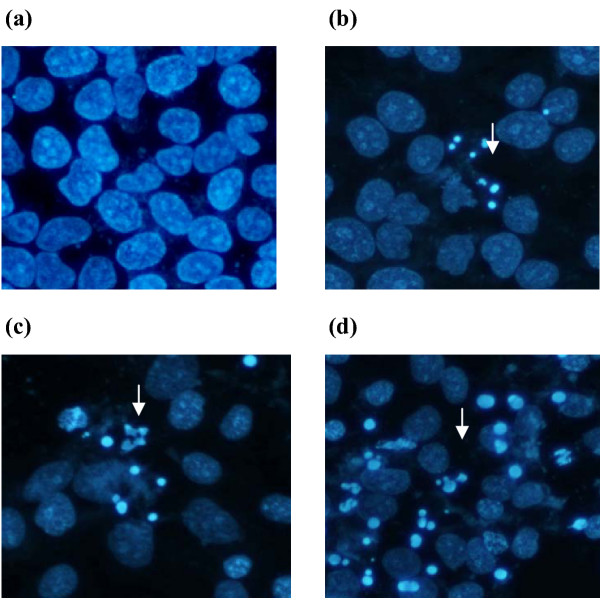
Apoptosis induced by bis-aziridinylnapthoquinone (AZ-1) in BC-M1 cells. The BC-M1 cells were treated in 24-hour culture with (a) dimethylsulfoxide control, (b) 0.2 μM AZ-1, (c) 1.0 μM AZ-1, or (d) 2.0 μM AZ-1 before Hoechst staining and analysis of the DNA nuclei. Apoptotic cells showed as blue, peripherally clumped or fragmented chromatin as indicated by the arrows.